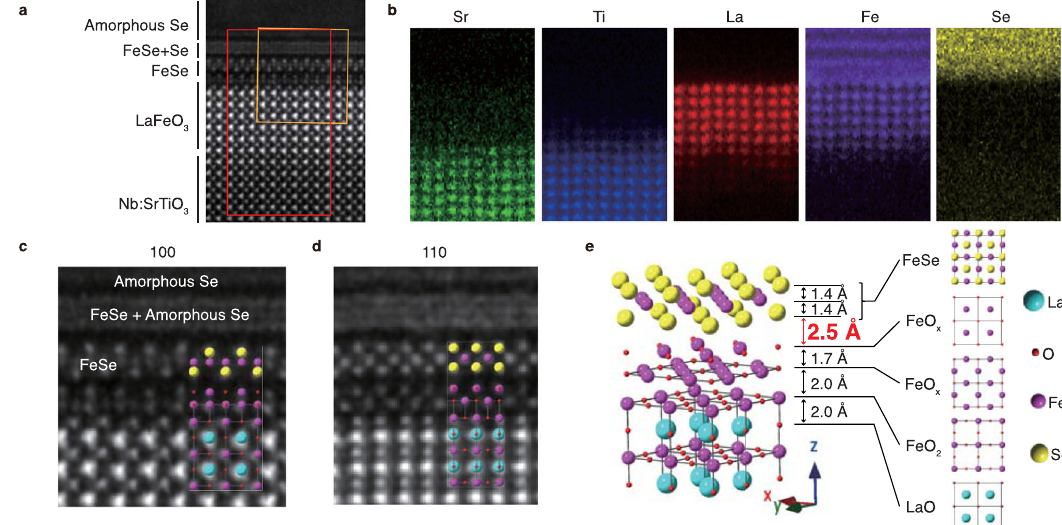
Fig. 1 Interfacial atomic structure of a -Se capped 1.5uc FeSe/LFO/STO. a High-angle annular dark fi eld (HAADF) image of amorphous Se capped 1.5uc FeSe/LFO/STO along the [100] direction of the STO lattice. b Element-resolved maps based on the EELS data at Sr- L 2,3 , Ti- L 2,3 , La- M 4,5 , Fe- L 2,3 , and Se- L 2,3 absorption edges. The region is shown by the red rectangle in panel a . FeSe layer that is atomically resolved in HAADF-STEM loses atomic resolution in element maps due to the dose damage from the much more intense electron beam used during element maps. c Zoomed-in HAADF image near the FeSe/ LFO interface, and the side view of the atomic structure is illustrated. The region is shown by the orange rectangle in panel a , d Same as panel c , but along [110] direction of the STO lattice. e Illustration of the resolved interfacial atomic structure at FeSe/LFO interface (see Supplementary Note 2 for some details on analysis).